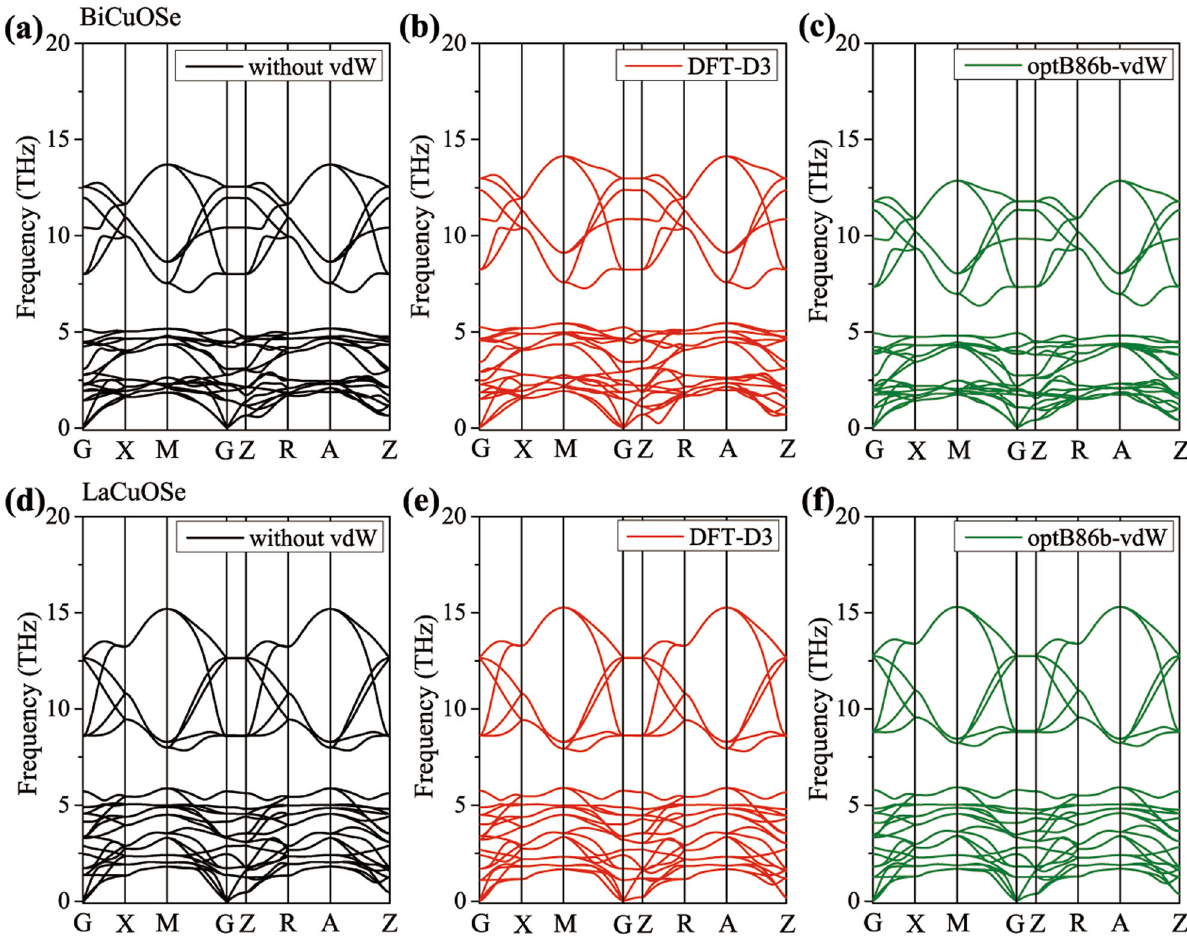
Fig. 9 Effects of vdW correction on phonon structure. The calculated phonon spectra for BiCuOSe ( a – c ) and LaCuOSe ( d – f ) with and without vdW